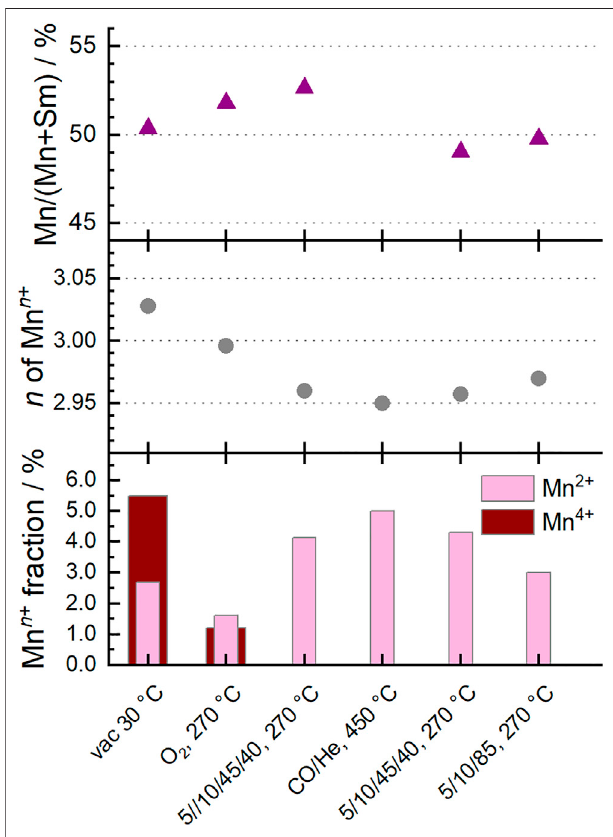
FIGURE 4 | Surface characteristics of Sm 0.96 MnO 3 at 0.25 mbar at different temperatures and different feeds (C 3 H 8 /O 2 /He/H 2 O) as given on the x -axis. Bottom: Fraction of Mn 2+ and Mn 4+ of all Mn ions measured with NEXAFS. Values obtained from NEXAFS Mn L 2,3 -edge fi tting. Mn 3+ balances the rest. Middle: Corresponding average oxidation state n of Mn n + . Top: Mn fraction obtained from Mn 2p and Sm 3d XPS peak area analysis.